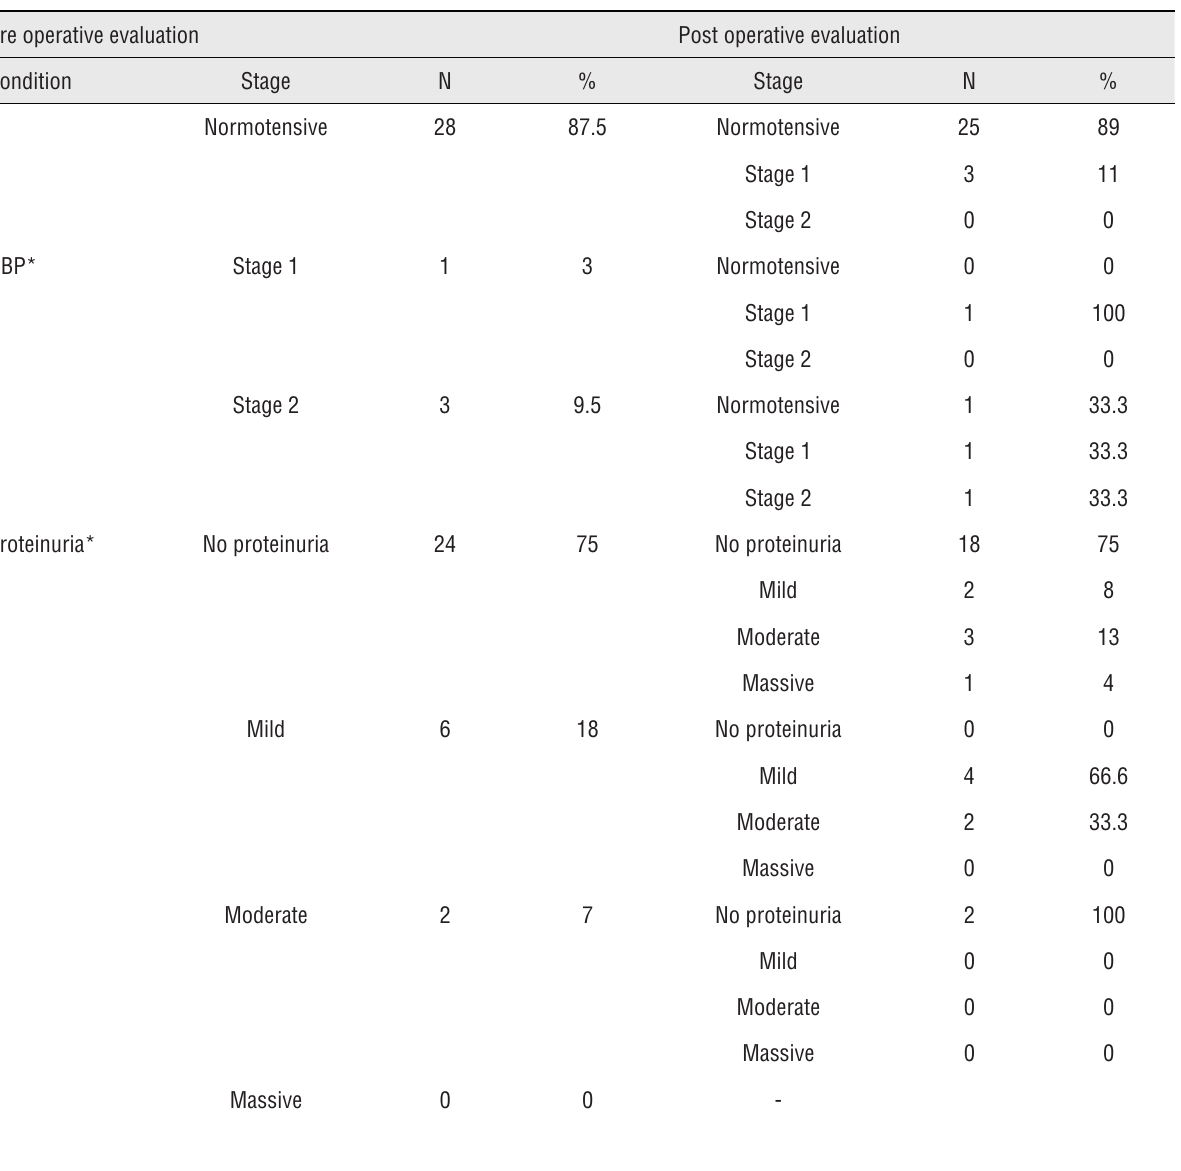
Table 1 - Pre and post- operative evaluation of patients who underwent unilateral nephrectomy for non-oncological condition. Pre operative